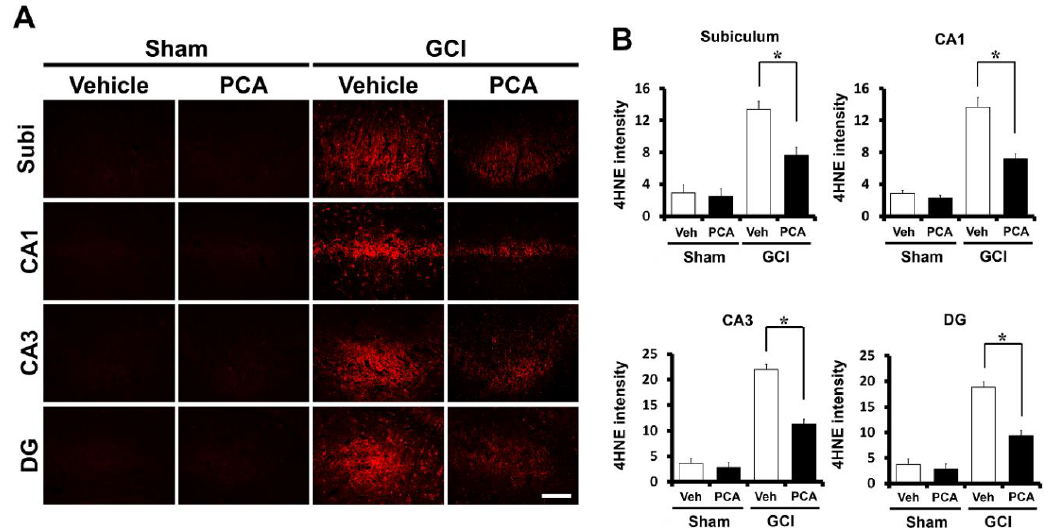
Figure 3. PCA treatment reduces oxidative damage after ischemia. Neuronal oxidative damage was detected by 4HNE (red color) staining in the hippocampal CA1, CA3, DG (dentate gyrus) and subiculum area at seven days following ischemia. As shown in Figure 2, PCA treatment alleviated damage by oxidative stress in the CA1, CA3, DG, and subiculum after insult. ( A ) Sham-operated groups display minimal 4HNE staining in the hippocampus. Oral injection of PCA for 1 week reduced the intensity of the 4HNE fluorescence compared to the saline-treated group after ischemia. Scale bar indicates 100 µm. ( B ) The bar graph shows the 4HNE fluorescence intensity in the CA1, CA3, DG, and subiculum. The fluorescence intensity reflects a significant distinction between saline- and PCA-treated groups. Data reflect the mean ± S.E.M., n = 5 from each sham group. n = 9 from each global ischemia group. * Significantly different from the vehicle-treated group, p < 0.05.